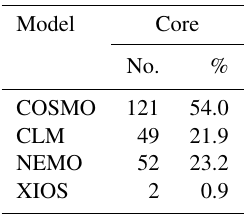
Table B1. Intermodel load balancing. XIOS is the NEMO I/O pro- gram, which is run as a separate executable. f.ETISh is not listed here, as it is run in between NEMO–CCLM 2